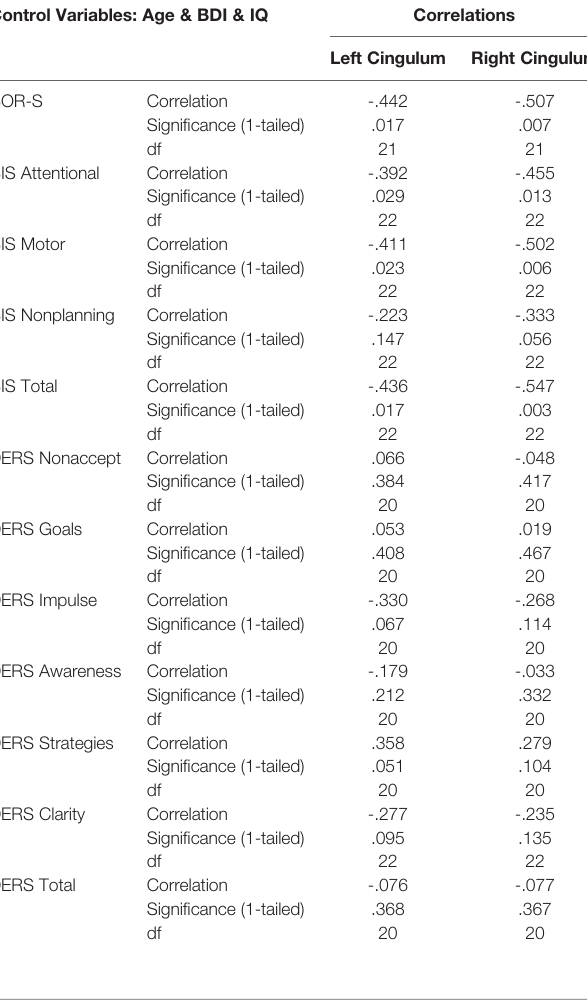
TABLE 4 | Duration of non-suicidal self-injury (NSSI) and cutting frequency and GFA correlations. Control Variables: Age & BDI & IQ